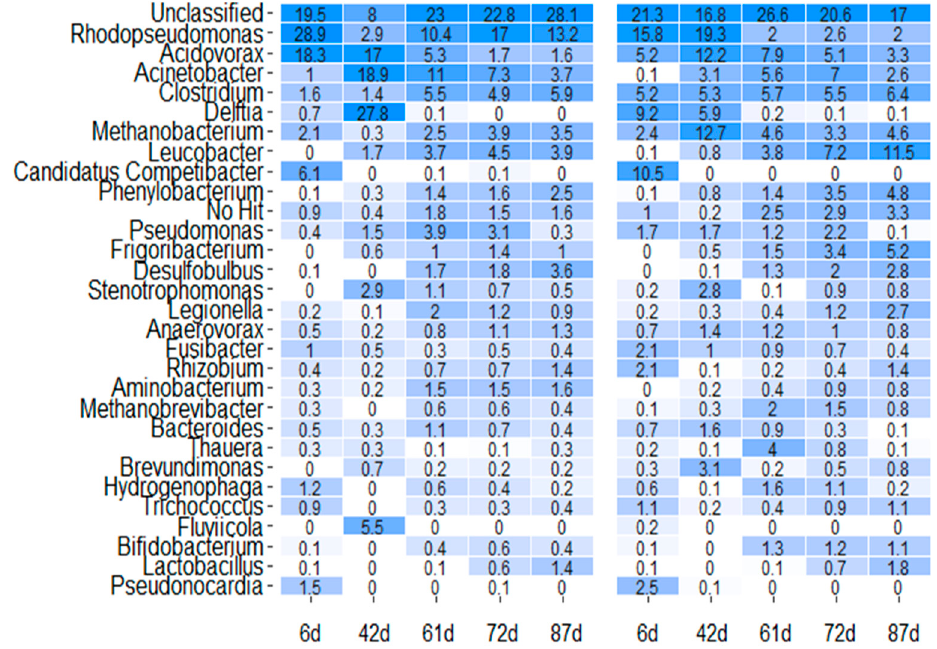
Figure 5. Heatmap presenting the percentage of sequences belonging to particular taxa in MFC1 and MFC2; in the bottom row, days of MFC operation are